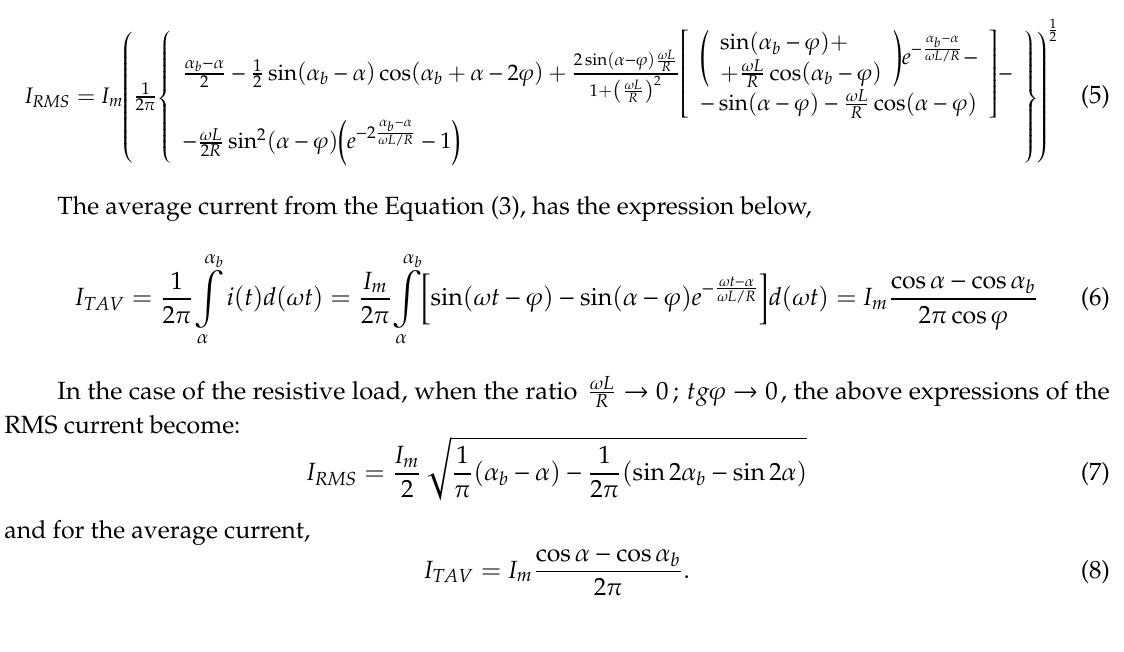
Figure 2. Current and power loss variation in time ( I = 200 A, R = 1.4 Ω , L = 30 mH, α = 60 °el.).